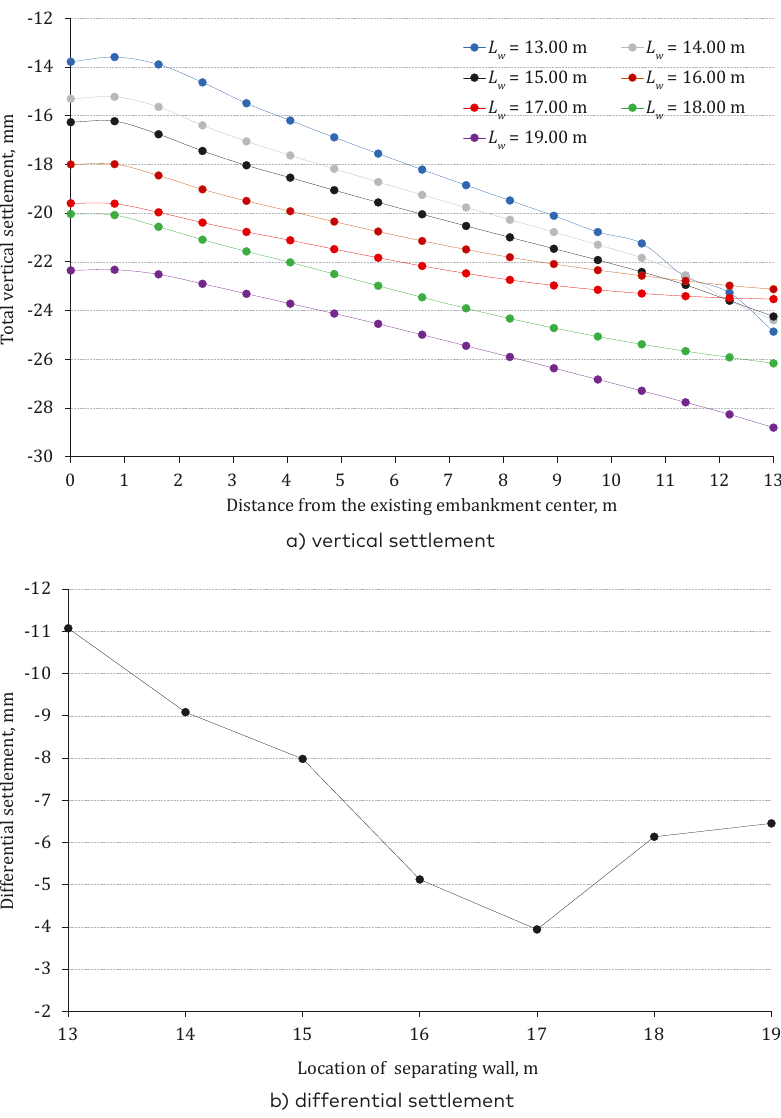
Figure 7. Effect of the